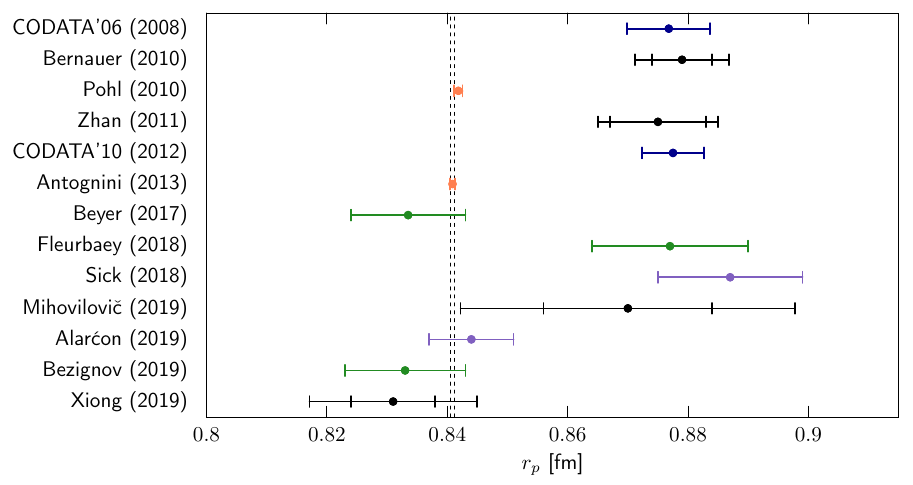
Figure 1. Collection of experimental results on the proton charge radius, and a (small) selection of fits by other authors. CODATA values (dark blue) [3, 46] are global fits, using electron spectroscopy and scattering data as input. Bernauer [2], Zhan [47], Mihoviloviˇc [44] and Xiong [45] (black) are results from scattering experiments, sometimes including the world data set. Sick [21] and Alar´con [17] (purple) are refits of existing data, in the latter case based on dispersion relations. Beyer, Fleurbaey and Bezignov [40–42] (green) are electron spectroscopy results, Pohl and Antognini [1, 5] (orange) are the results from the muon spectroscopy